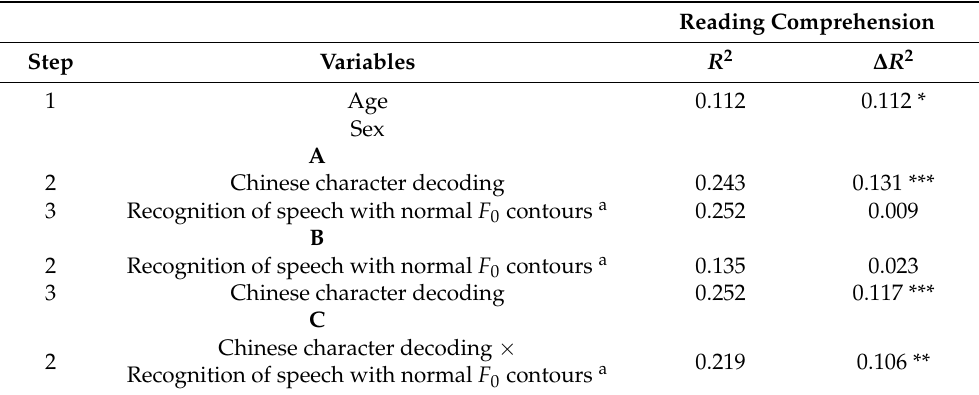
Table 3. Hierarchical regression analyses predicting reading comprehension from Chinese character decoding and recognition of speech with normal F 0 contours.